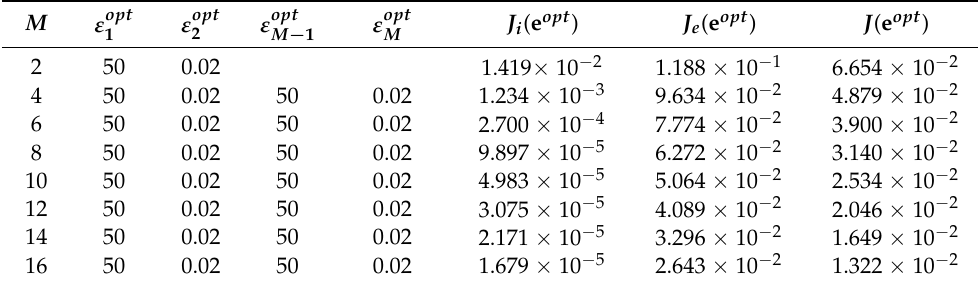
Figure 5. Schematic of optimal six-layered isotropic shells obtained when solving shielding ( a – c ) or cloaking ( d – f ) problems for three different pairs ( ε min , ε max ) given in (31) [the first pair—( a , d ); the second pair—( b , e ); the third pair—( c , f )]. Table 1. Results of solving shielding problem for ε min = 0.02, ε max = 50; R a = 0.035, R b = 0.050, R = 0.1, Contrast =